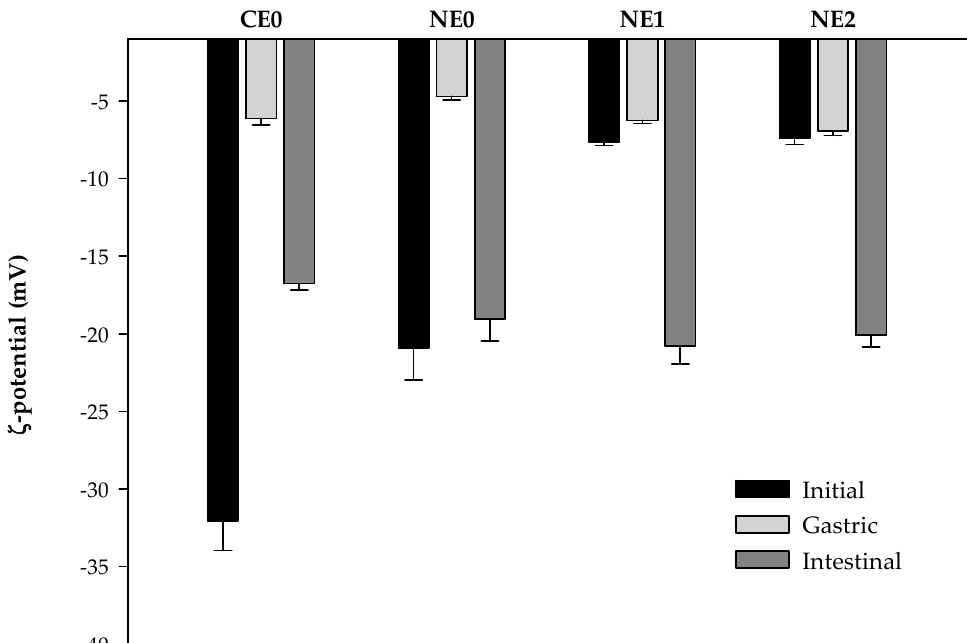
Figure 7. ζ -potential values of coarse emulsion and nanoemulsions with different pectin concentrations (0%, 1%, and 2%) at different phases of the in vitro digestion. CE0, coarse emulsion without pectin; NE0, nanoemulsion without pectin; NE1, nanoemulsion with 1% of pectin; NE2, nanoemulsion with 2% of pectin.